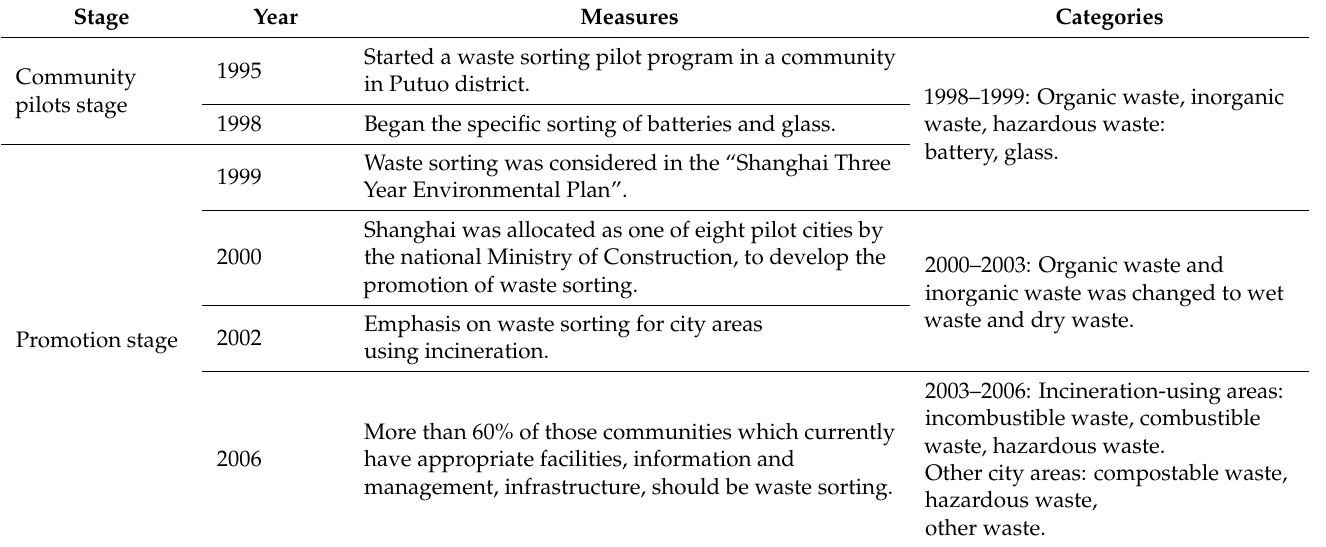
Table 1. A chronological summary of steps and stages in Shanghai’s development of a waste sorting policy, showing how they led up to the city-wide integrated regulations [16] for all stakeholders in July 2019. The stages were not pre-planned in this specific manner but were retrospectively labelled as such and are now viewed in this